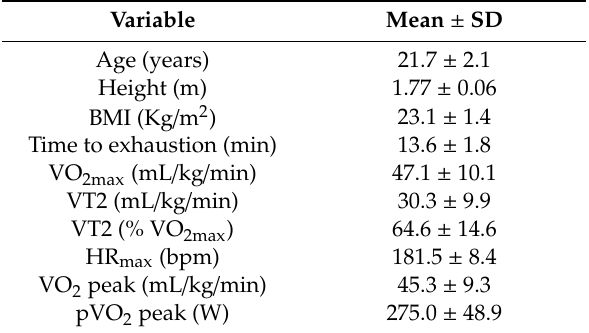
Table 1. Subjects’ characteristics and performance during the graded exercise test (session 1). Variable